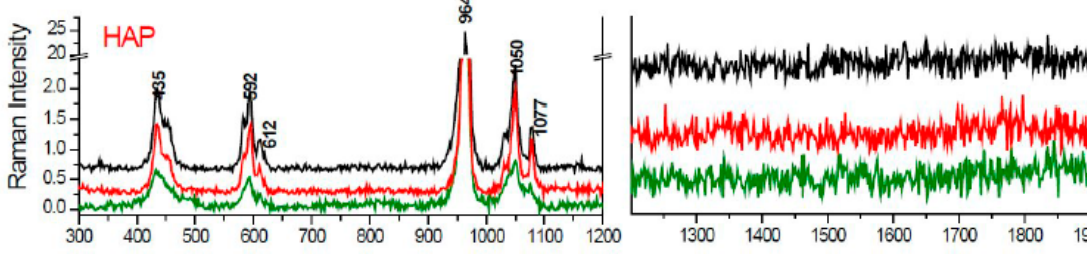
Figure 4. Raman spectrum of HAp synthetized in the laboratory.